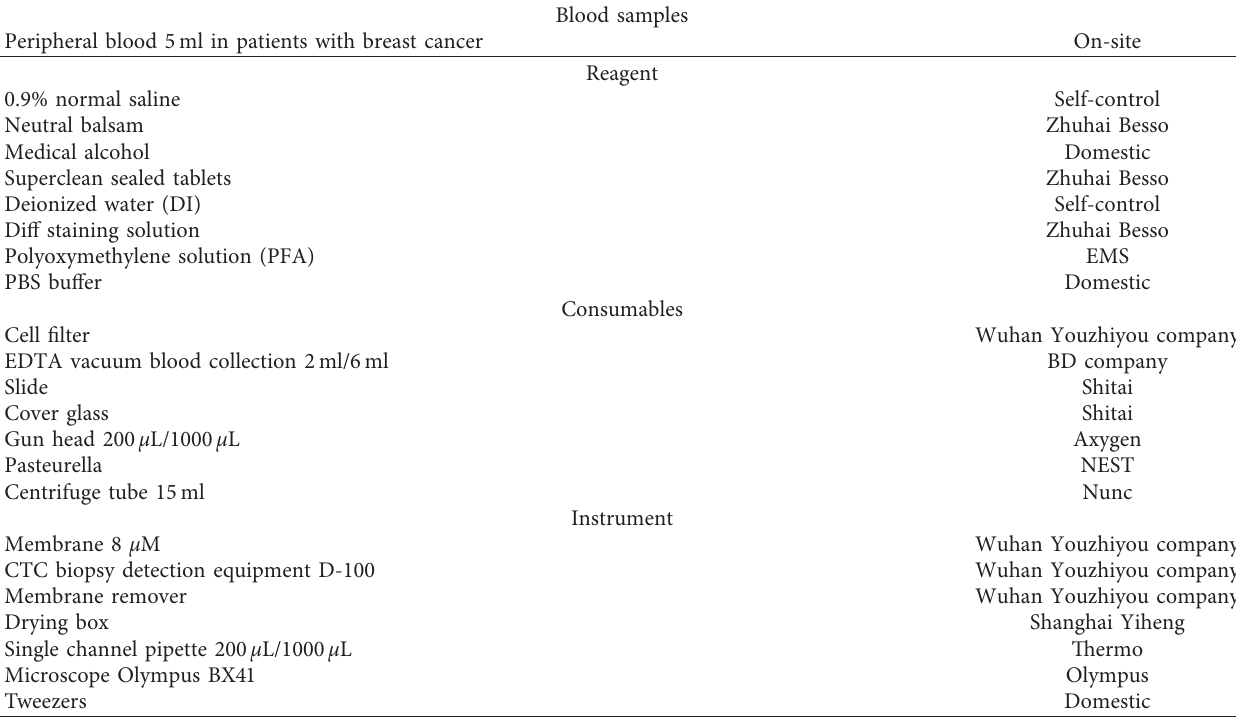
Table 1: List of experimental materials and